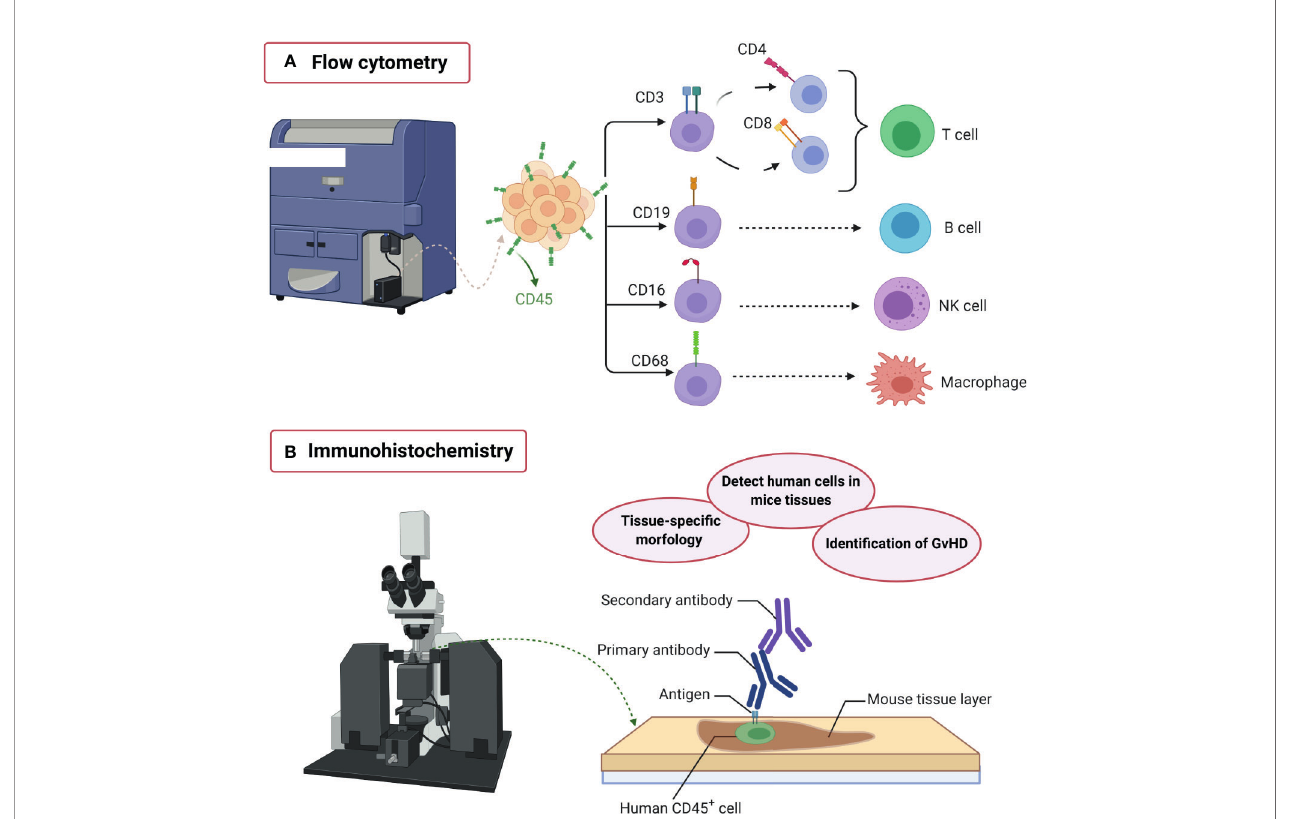
FIGURE 3 | Humanized mice model characterization. The diversity of graft sources and receptors for humanization often needs an extensive immune cell subpopulations ’ pro fi ling in order to discriminate the desired human-like immune response from the graft- versus -host-disease (GvHD) xenogeneic immune response. For this purpose, fl ow cytometry and immunohistochemistry have been used. (A) Flow cytometry: The use of multiple fl uorochrome-labeled antibodies allows the identi fi cation of different immune cell lineages at the same time. The CD45 + peripheral blood mononuclear cells (PBMCs) can be further classi fi ed, for example, into CD3 + CD4 + /CD8 + T cells, CD19 + B cells, CD16 + natural killer cells, or CD68 + macrophages, which are characteristic of a human-like periodontal immune response. (B) Immunohistochemistry: Tissue labeling allows the spatial identi fi cation of human cells in mice tissues, the visualization of their interaction with periodontal tissue- speci fi c morphology, and the identi fi cation of GvHD lesions. Created with